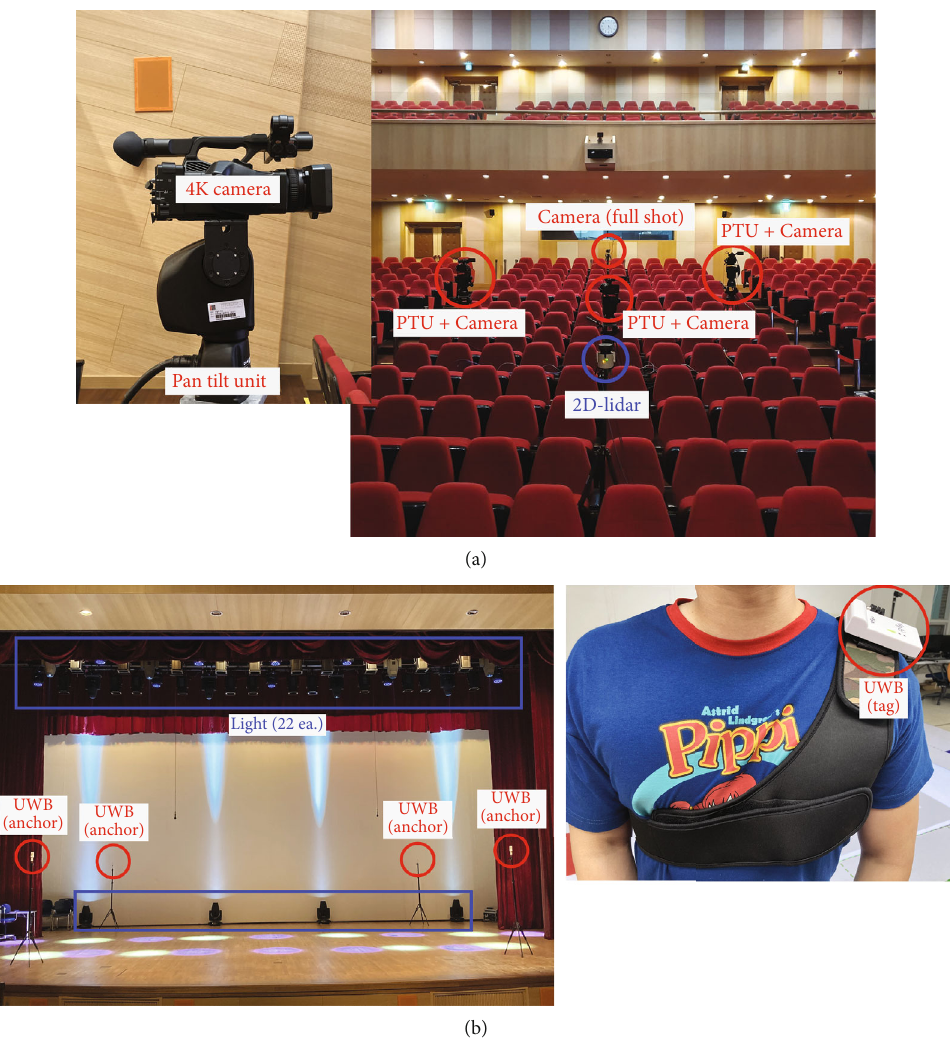
Figure 4: Hardware settings used in this study, (a) A PTU for controlling pan and tilt and a 4 K camera for video recording. An environment in which PTU +camera and 2D LiDAR sensor are installed in front of the stage to acquire movement data and correct movement errors of actors, (b) 22 lights and UWB anchor for identi fi cation installed on the stage. A UWB tag in the form of a vest.